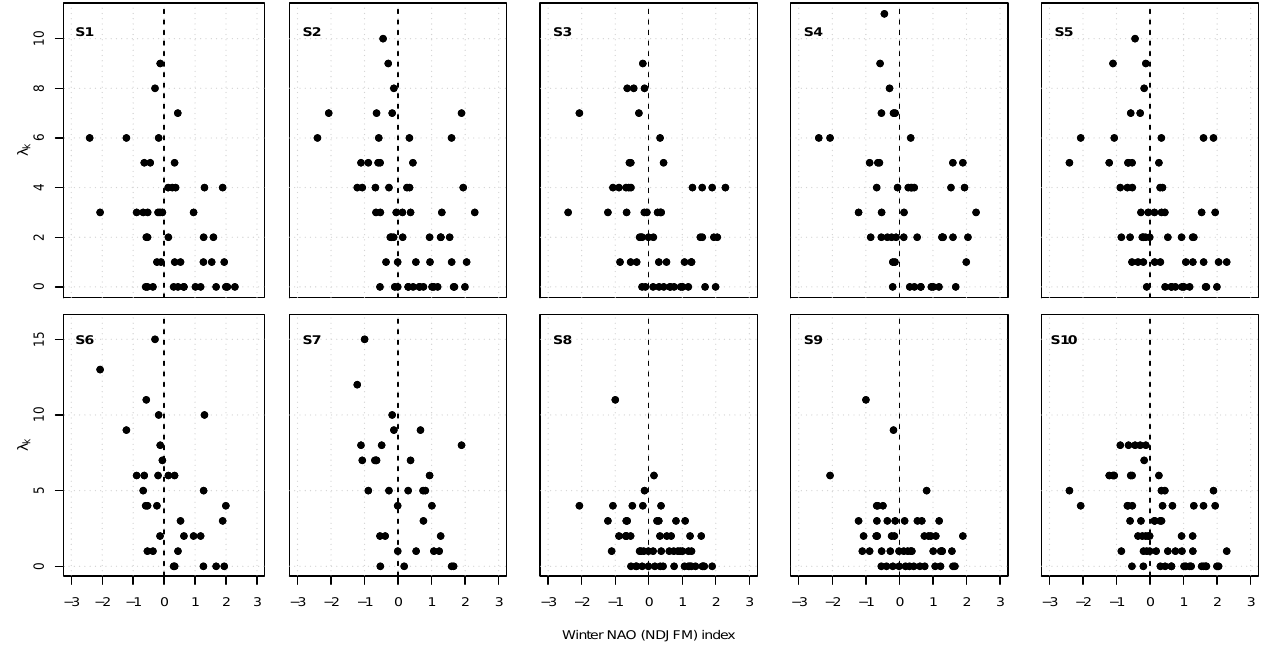
Fig. 10. Number of floods in a hydrologic year, λ k plotted against the winter NAO (NDJFM) index of the same year. Graphs are identified with the sample number in the top left corner.